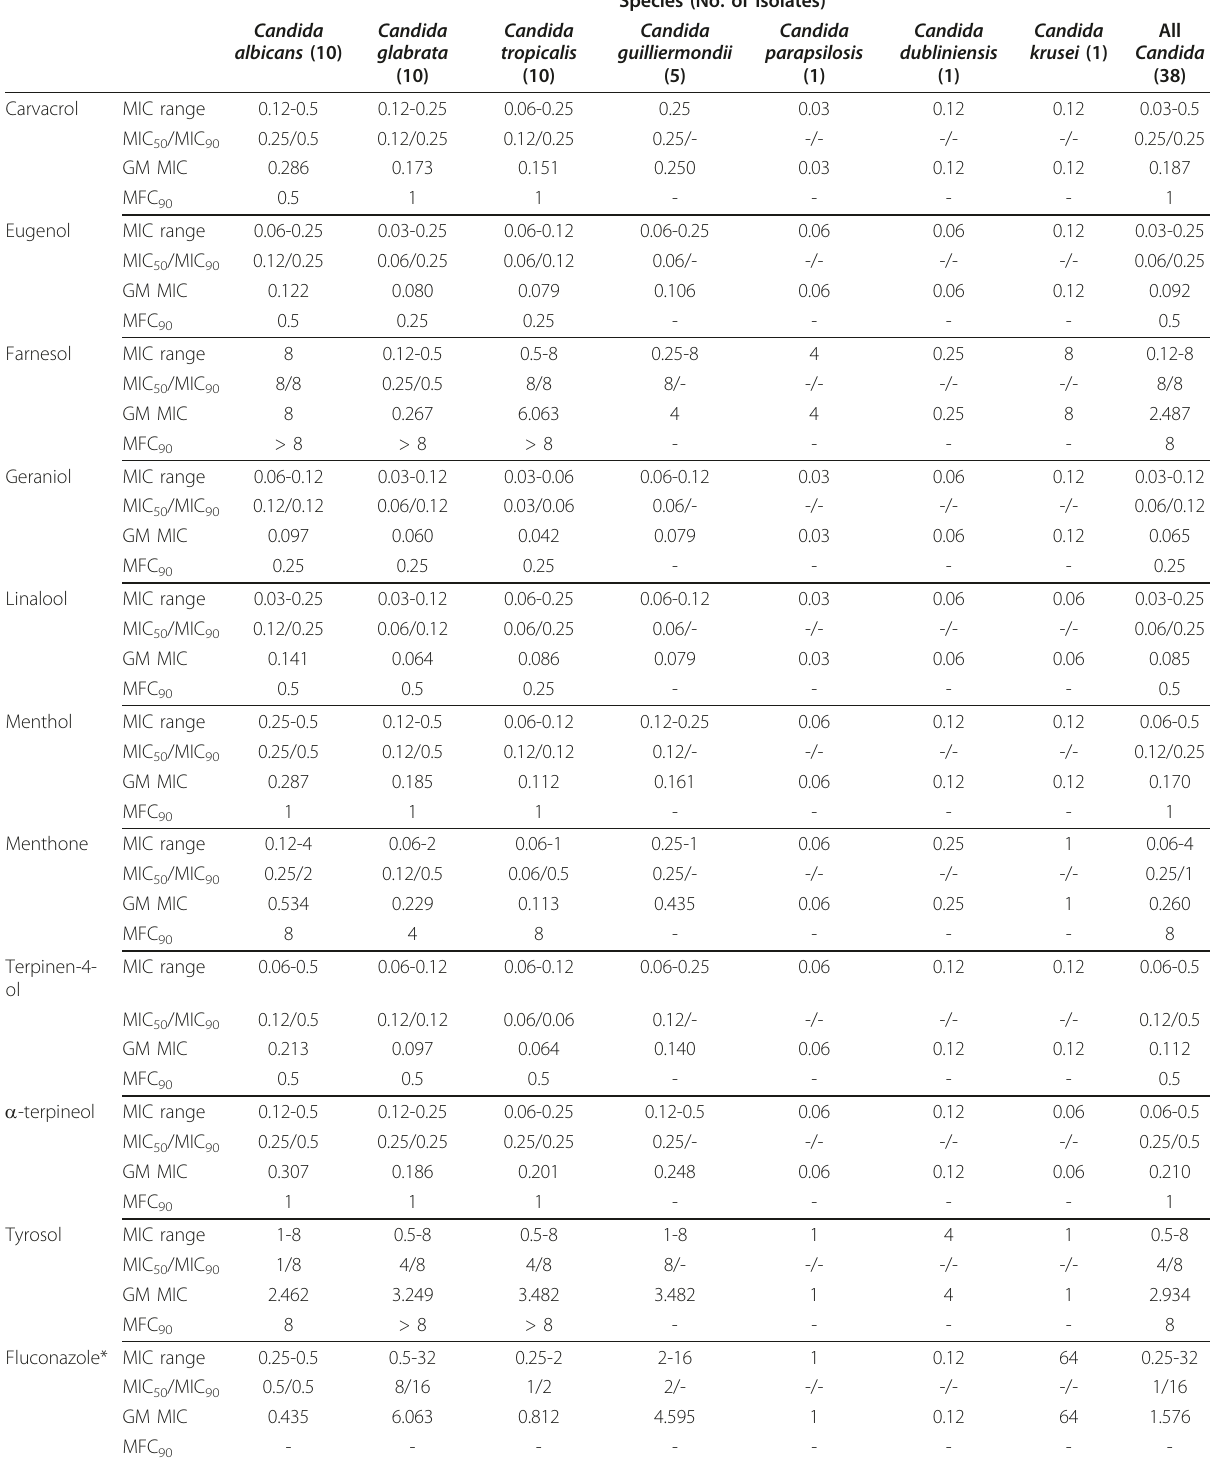
Table 2 In vitro antifungal activity of the ten natural compounds against oral Candida isolates at 24 h (%,